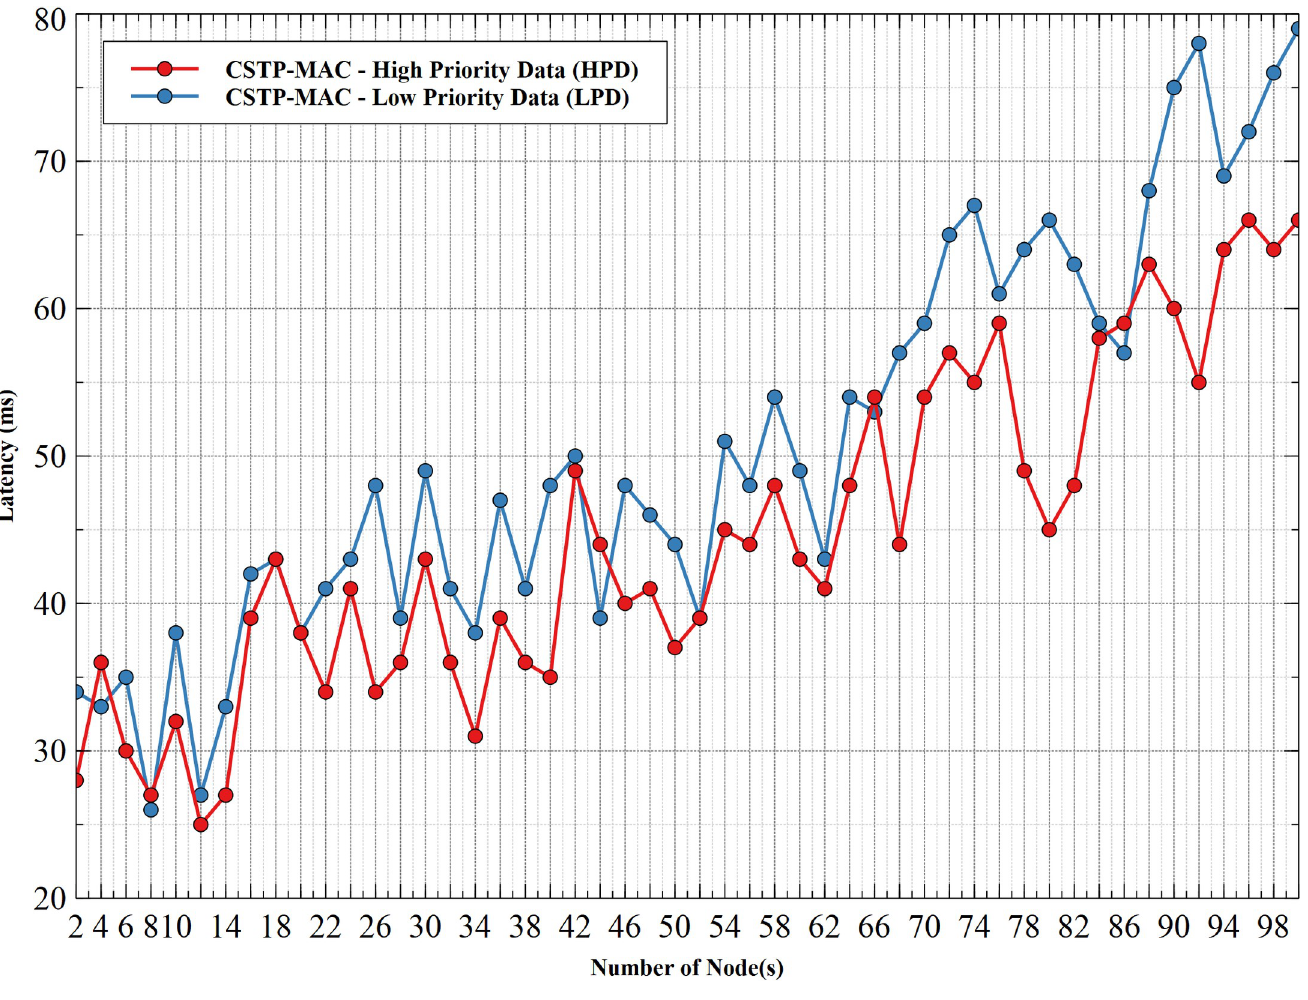
Fig 12. Latency–HPD vs